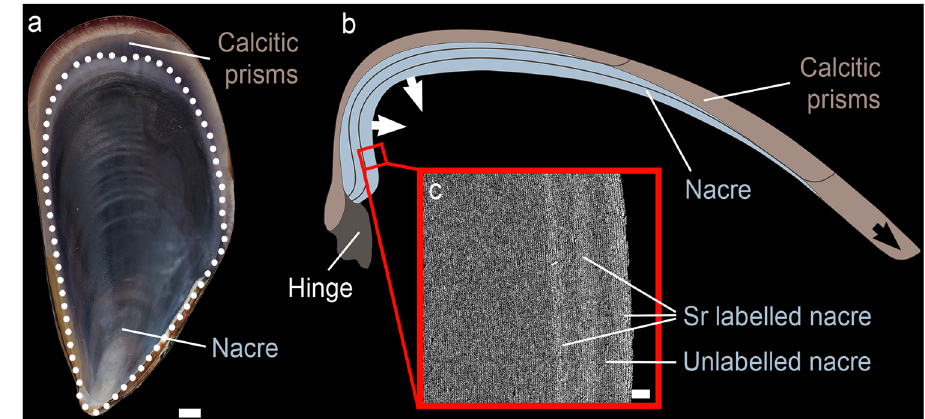
Fig. 1 | Nacre growthvisualised by Sr pulse-chase labelling. a Photo of the inner shell surface of a M. galloprovincialis shell showing nacre constituting most of the innershellsurfaceinsidethewhitedottedlineandprismaticcalciteoutsidetheline. b Schematic cross-section of a shell. The shell grows in length by extending the outercalcite layeralong the ventralmargin (blackarrow). The innernacreous shell layer extends by thickening the inner shell surface (two white arrows). c SEM-BSE